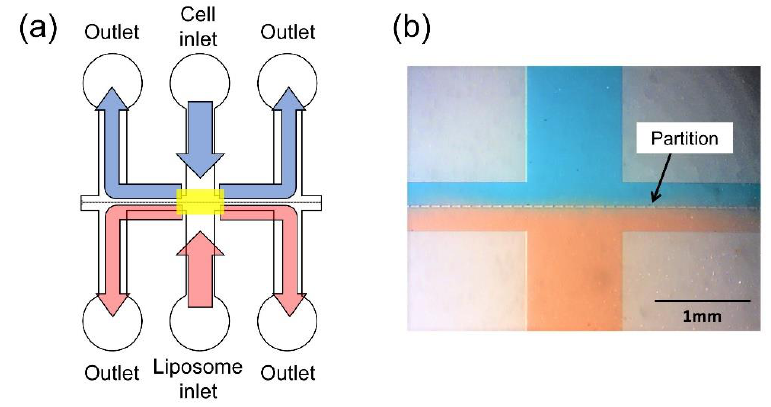
Figure 3. ( a ) The flow of cells and liposomes in the microchannel by capillary force. The introduced suspensions of cells and liposomes flowed towards each of the two outlets on both sides of the inlet. ( b ) Bright field image of red and blue solutions that were introduced in the microchannel at the yellow rectangle region of ( a ).